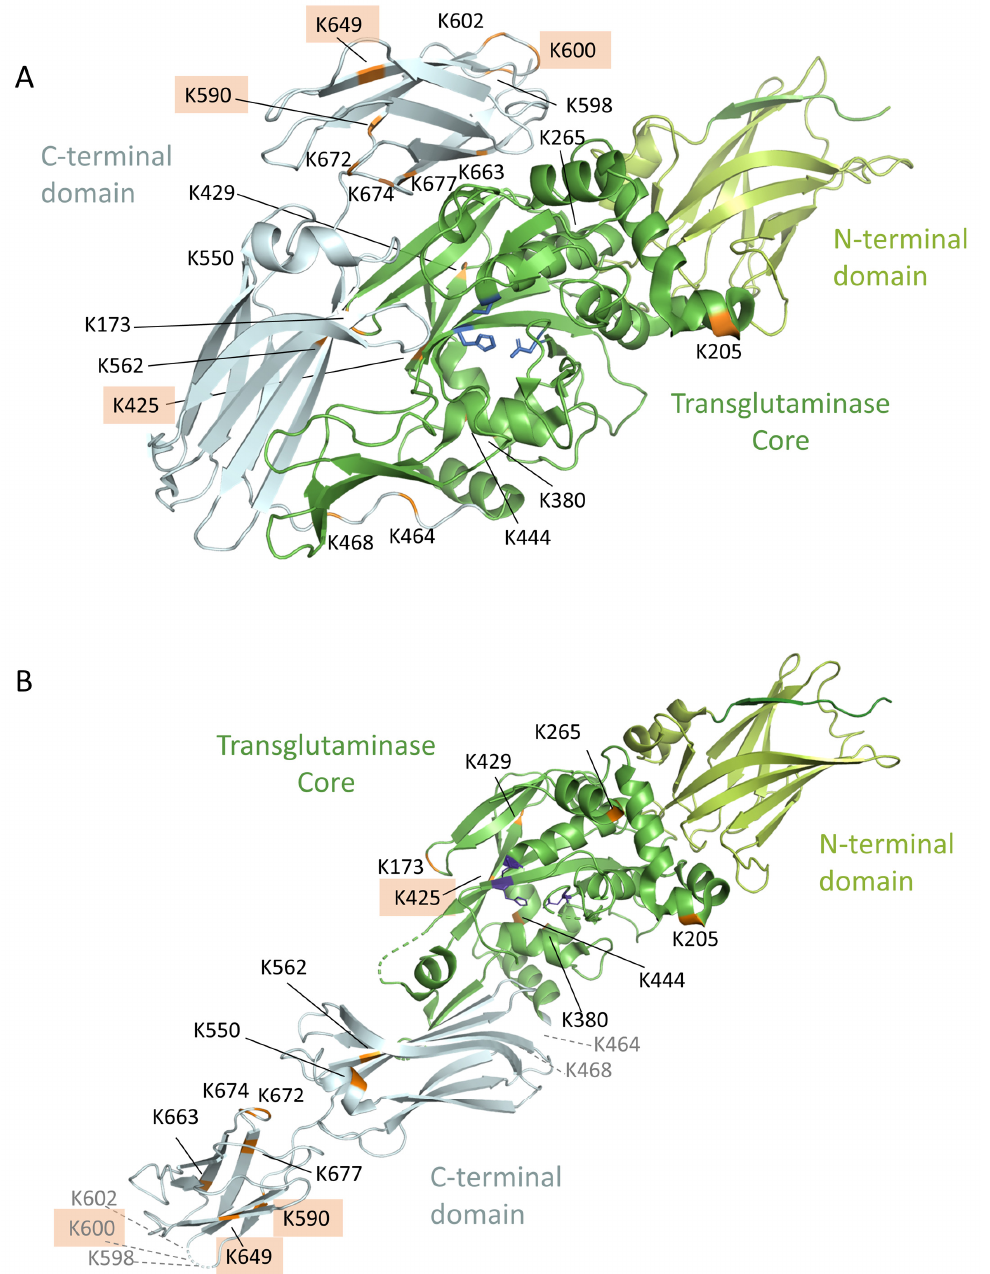
Figure 4. Location of the lysine residues identified crosslinked with the model peptide PepQ within the 3D structure of TG2. ( A ) 3D structure of the closed conformation (PDB ID code 4PYG). ( B ) 3D structure of the active open conformation (PDB ID code 3S3P); the lysine residues K464, K468, K598, K600, and K602 are not visible in this scheme, because these parts are not resolved in the crystal structure. The identified lysine residues are marked in orange, the four preferred lysine residues are highlighted, the catalytic triad is colored in blue, the C-terminal domain in grey, the core region in dark green, and the N-terminal region in light green.